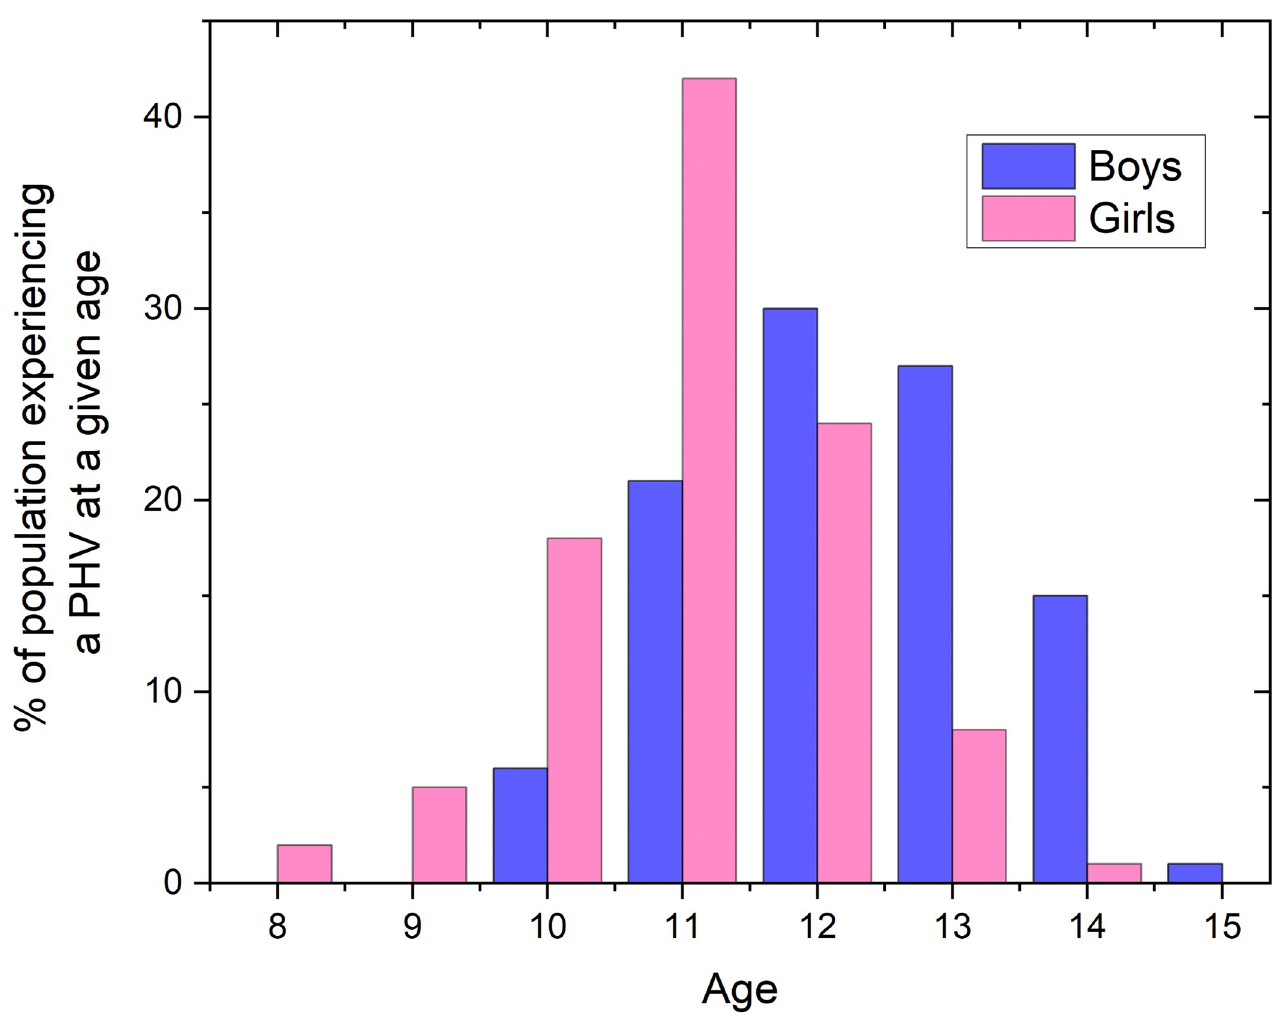
Fig 2. Age at which PHV begins for boys and girls in our dataset.